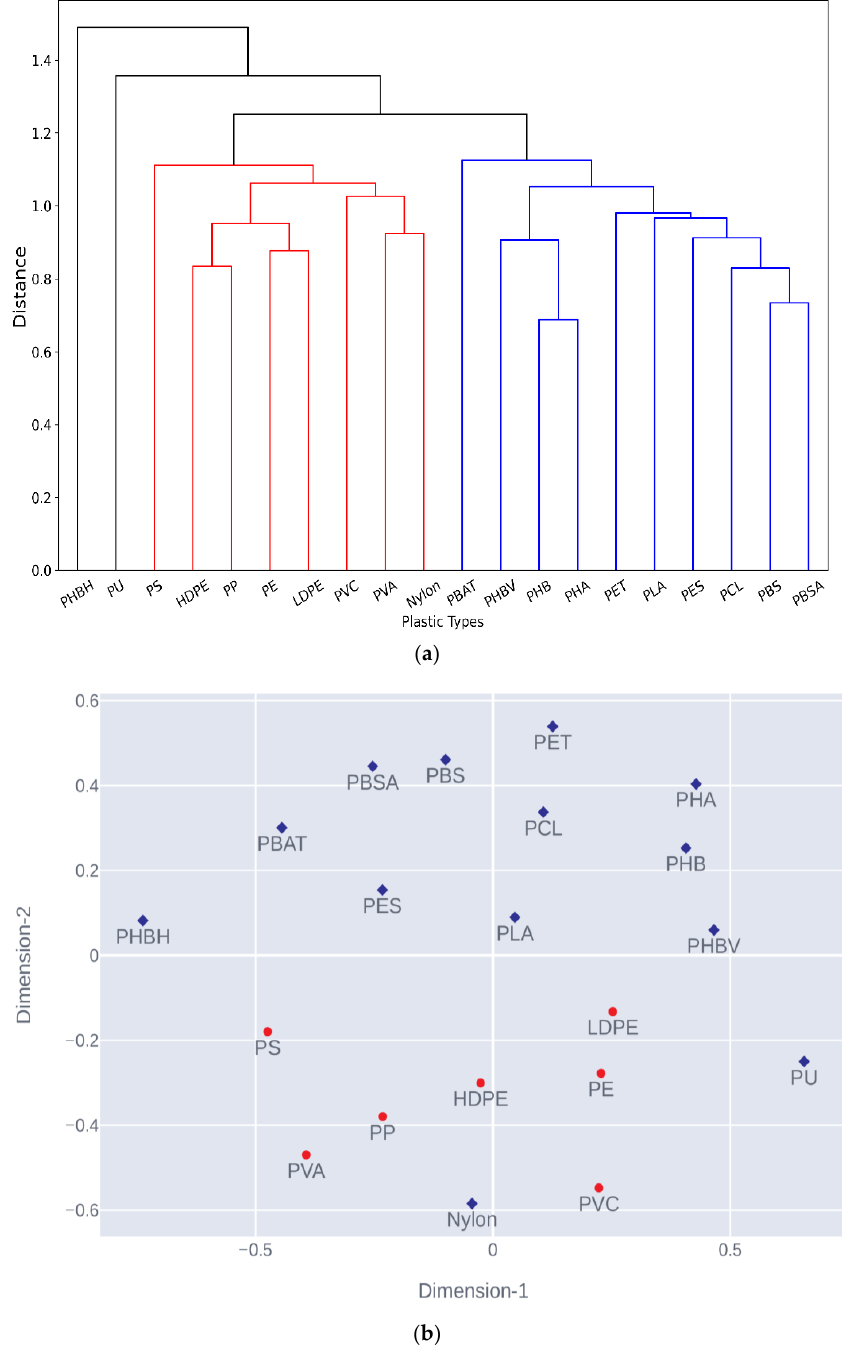
Figure 3. ( a ): Hierarchical clustering plot of plastic type cosine distance matrix computed from genus plastic association matrix. ( b ): Non-metric multidimensional scaling (NMDS) plot of cosine distance matrix computed from genus plastic association matrix where blue diamonds and red circles represent C-X and C-C types of plastics,